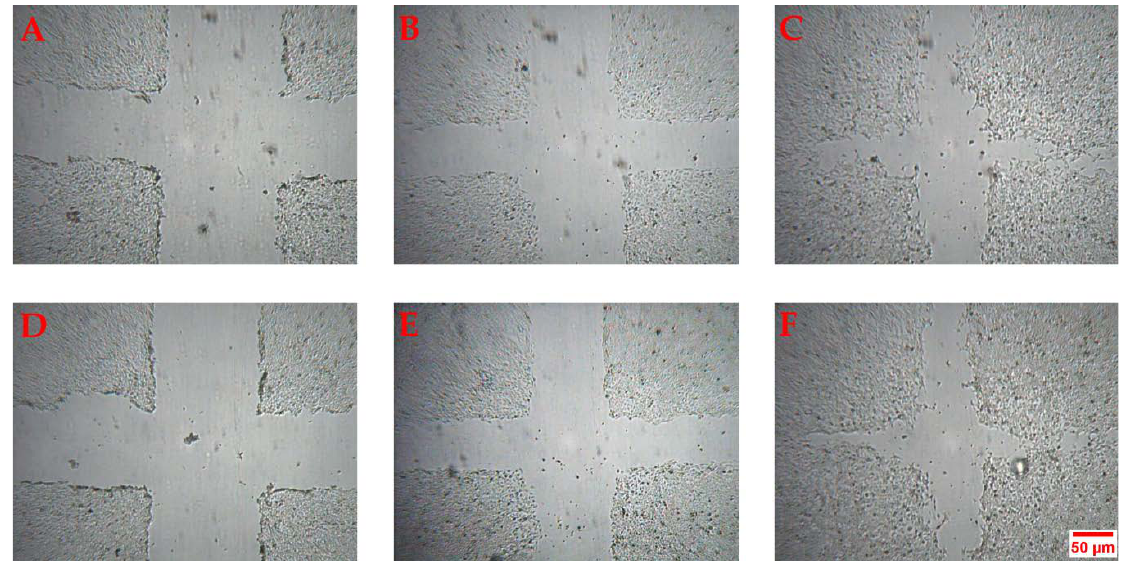
Figure 3. Representative images of the scratch wound healing assay. The images show the effect of Ctrl at t0 ( A ), 6 ( B ) and 24 h ( C ) and HM 10 μg/mL at t 0 ( D ), 6 ( E ) and 24 h ( F ).